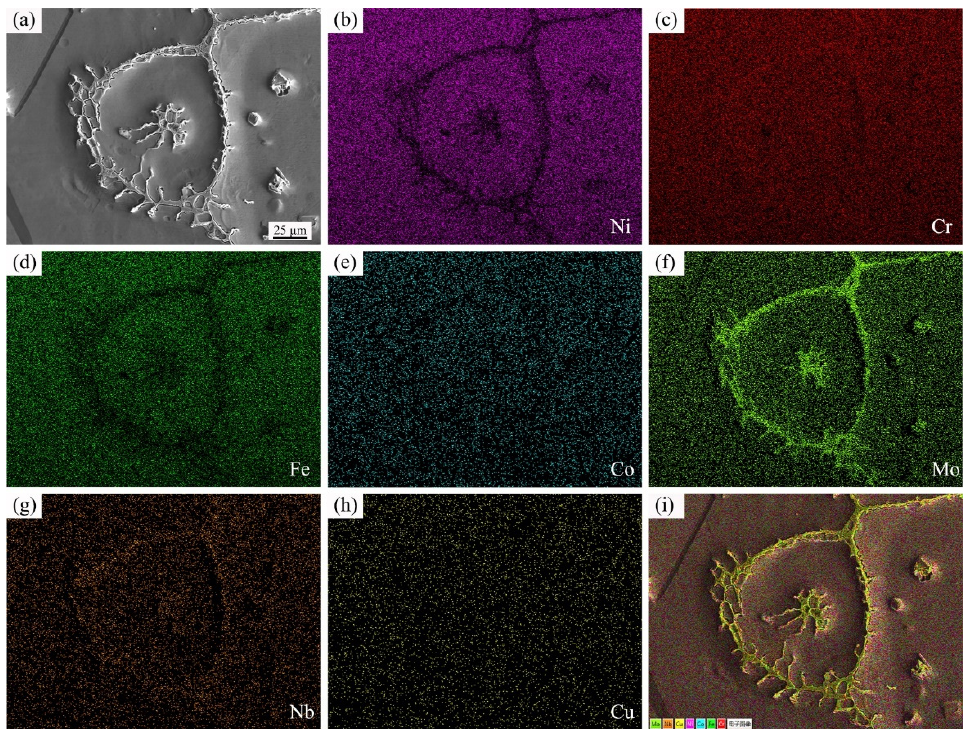
Figure 10. Map scanning of GH3536 alloy soaked at 1367 °C for 60 min: ( a ) SEM image, ( b ) Ni, ( c ) Cr, ( d ) Fe, ( e ) Co, ( f ) Mo, ( g ) Nb, ( h ) Cu, and ( i ) all alloying elements.